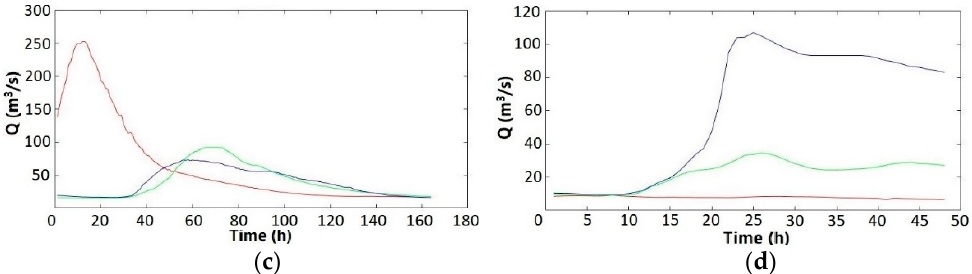
Figure 6. The hydrographs of three major rivers (red: Unternzettlitz, green: Ködntiz, blue: Kauern- dorf) in four real events ( a ) 2005, ( b ) 2006, ( c ) 2011, and ( d ) 2013.